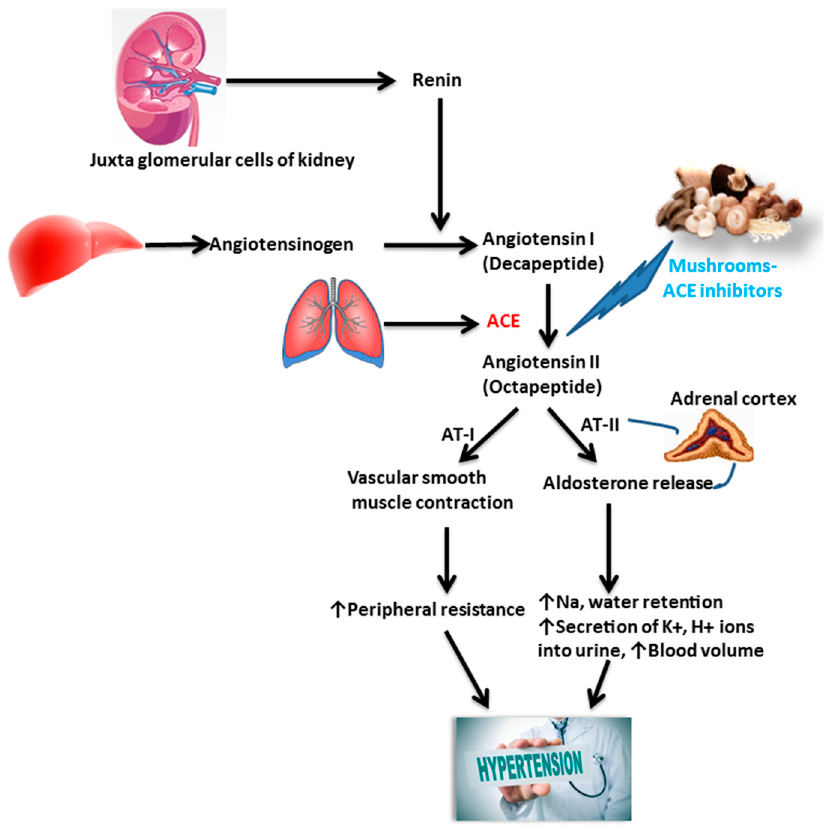
Figure 3. Antihypertensive effect of mushrooms—Mushrooms are found to be Angiotensin Converting Enzyme (ACE) inhibitors, which help to reduce hypertension by constraining ACE. This enzyme is accountable for transforming the inactive protein Ang I into the active Ang II. The renin-angiotensin system–angiotensin II has a multifaceted range of effects on the maintenance of blood pressure and this impact elevates sodium and water retention through the release of aldosterone.